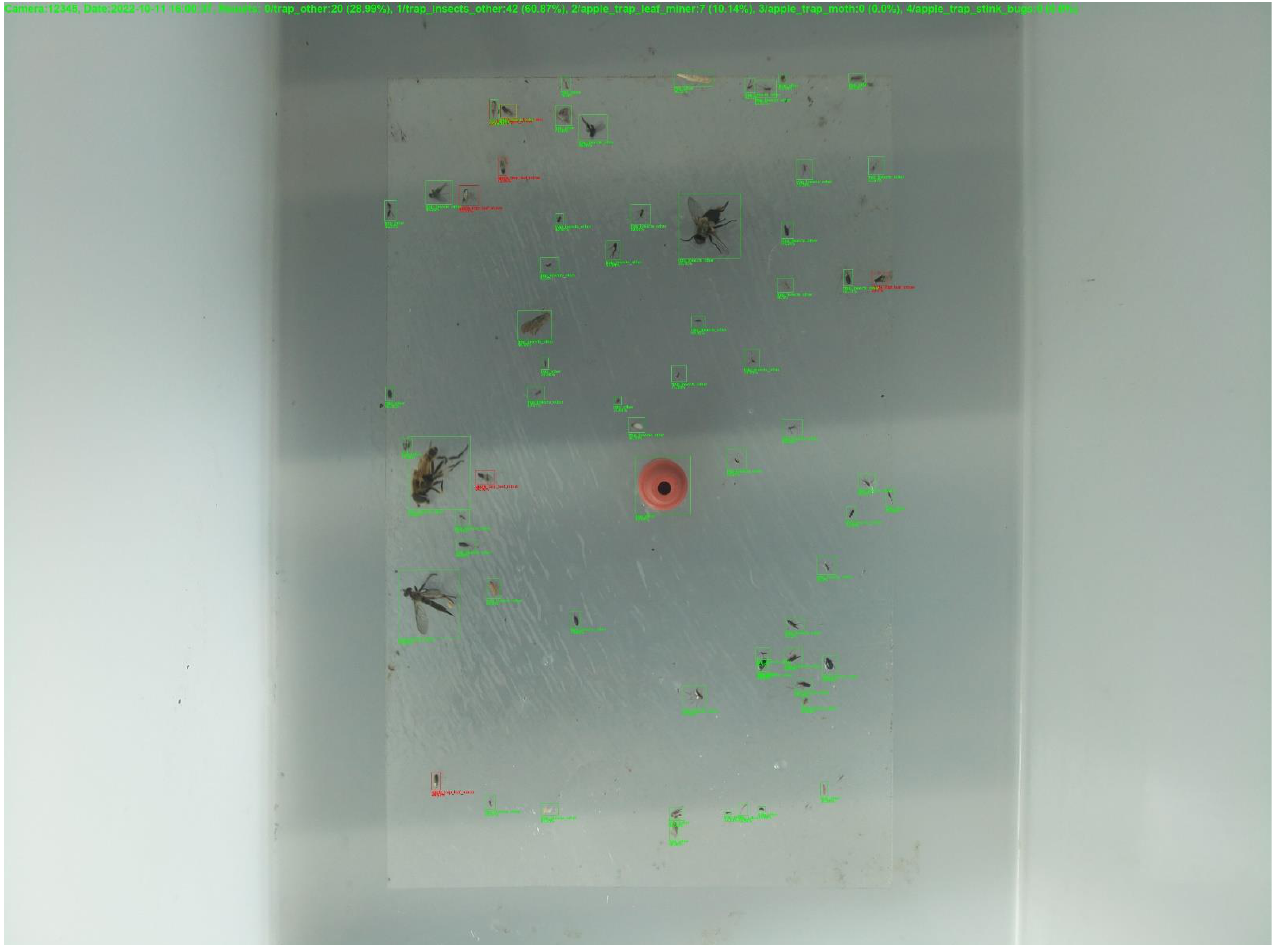
Figure 9. Example of the automatic counts of the model for the Pest Monitoring Device (PMD). Red bounding boxes – detected class MINER ( L. malifoliella adults), green bounding boxes – detected classes OTHER (other objects) and INSECT (other insects).